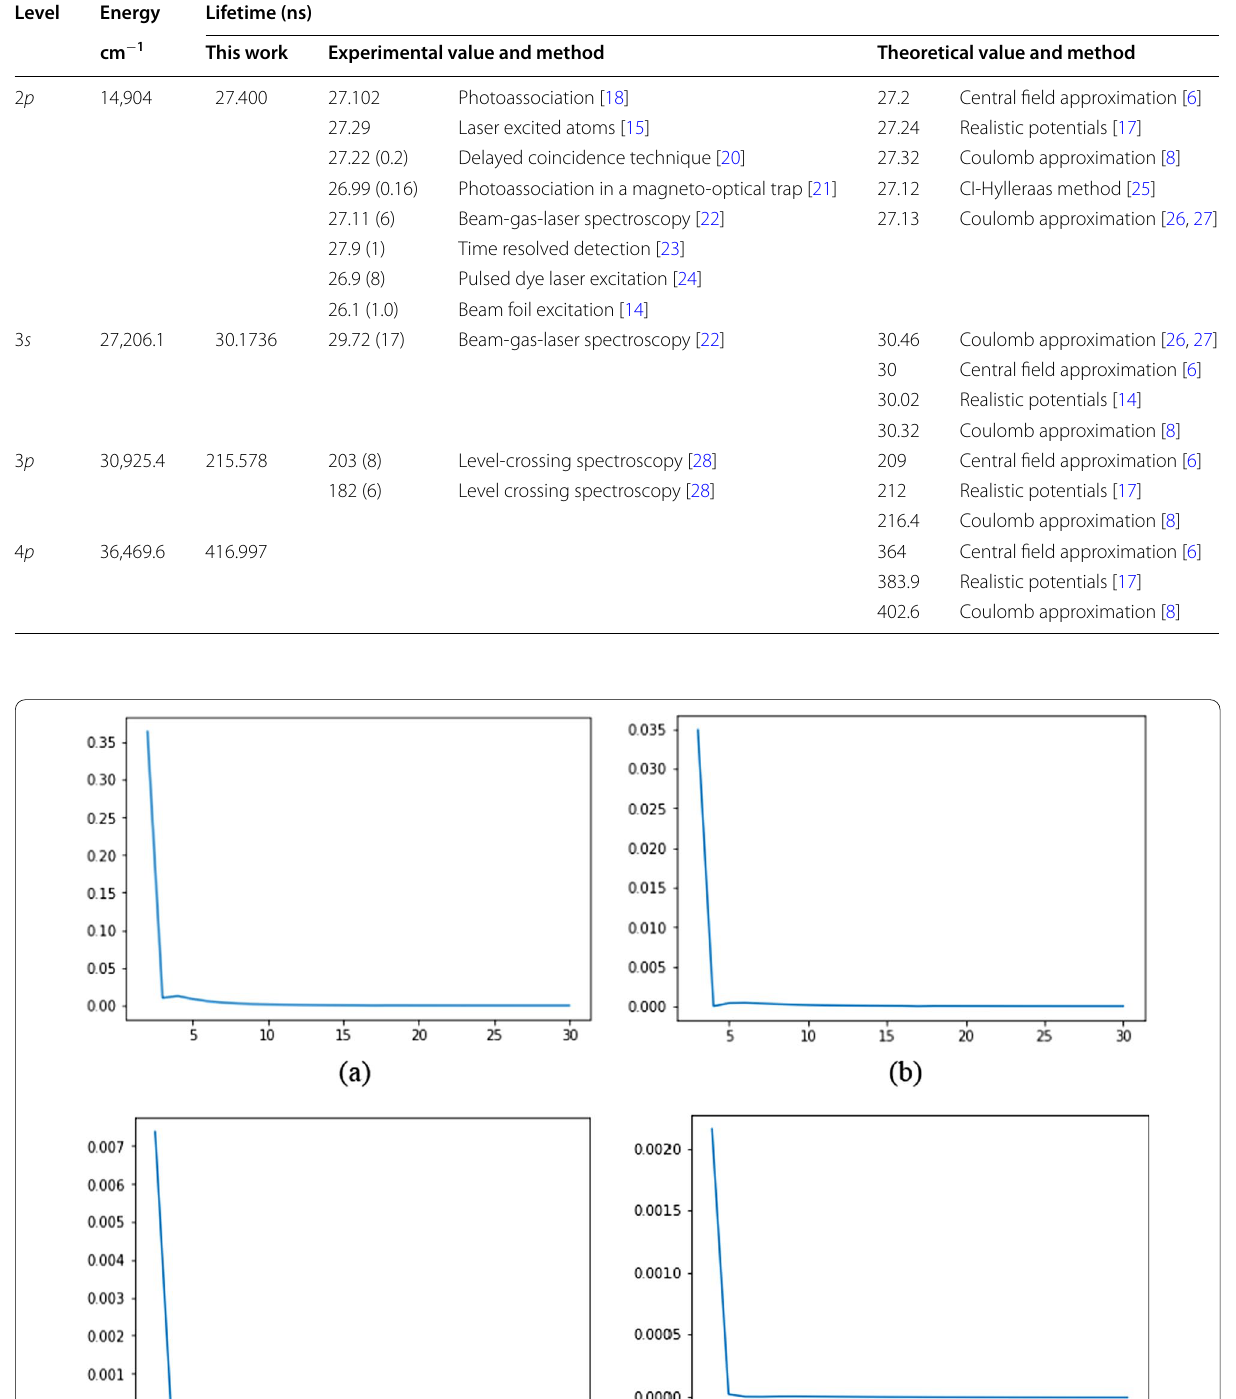
Table 5 Lifetimes of Li I’s 2 p , 3 s , 3 p , and 4 p states